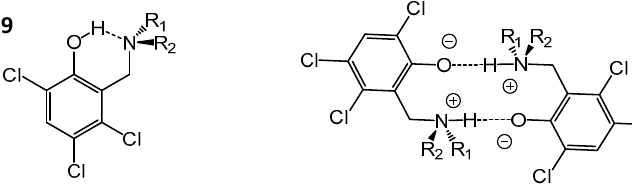
Figure 7. Schematic structure of ortho -hydroxyaryl Mannich base 9 ( left ) and its zwitterionic cyclic dimer ( right ), studied by NMR in [74].